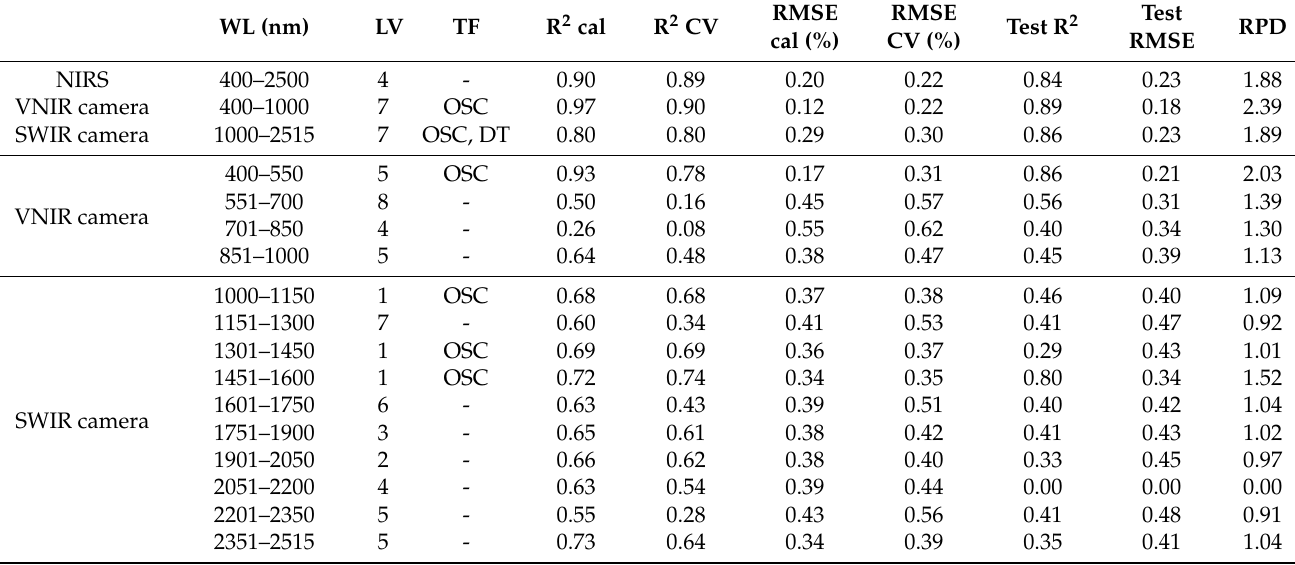
Table 2. Attributes of the PLSR models developed for predicting carbon (C) in the calibration and test